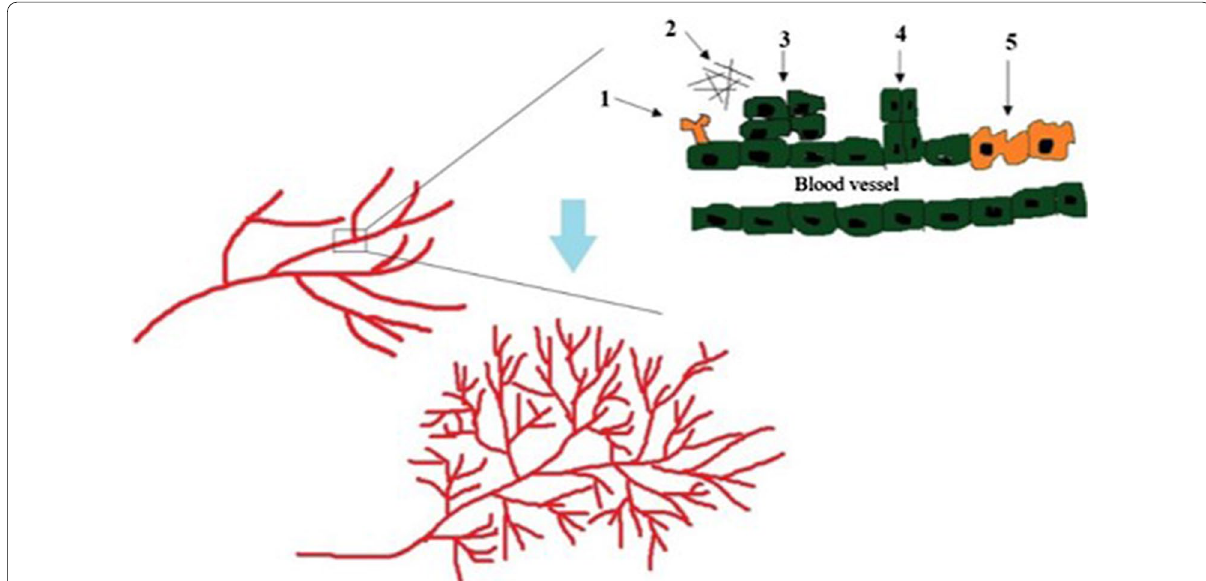
Fig. 1 Regulation of angiogenesis (Steps: 1. Angiogenic factors bind to endothelial cells, 2. Basement membrane degradation, 3. Endothelial cell proliferation and migration, 4. Tube formation, elongation and remodeling and 5. Vessel stabilization.)